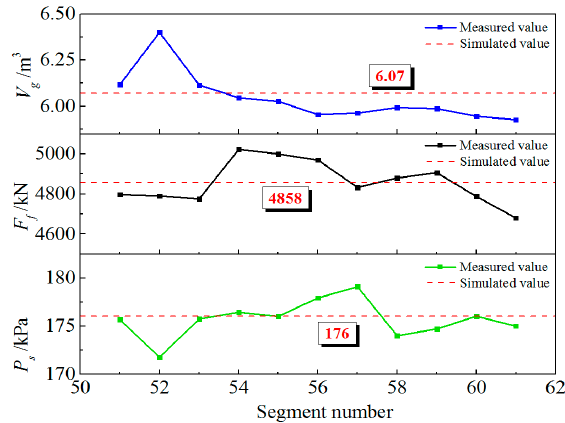
Figure 28. Excavation parameters at TY-56.